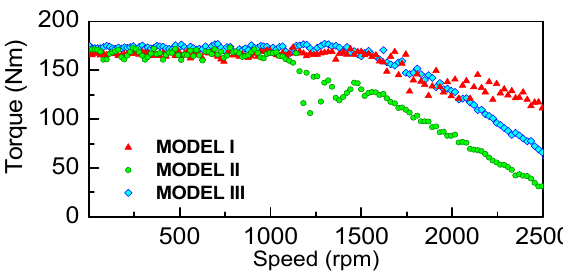
Figure 20. Torque-speed characteristic in different models under T e * = 190 Nm.